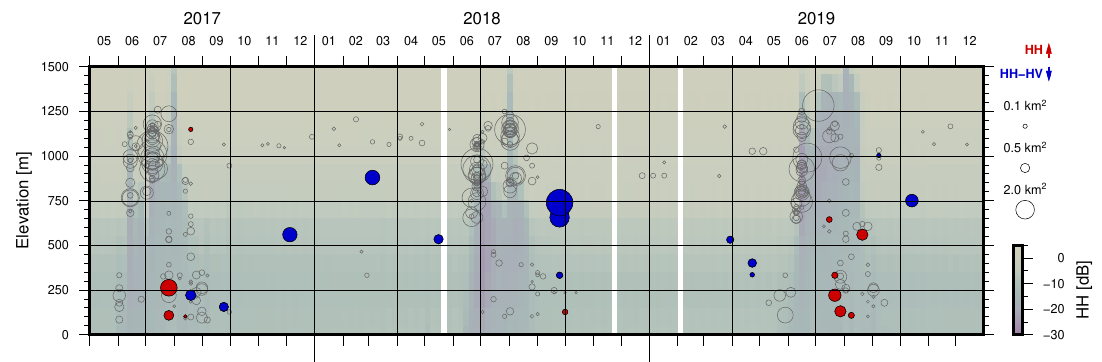
Figure 8. Supraglacial lake drainages (circles) detected by PolSAR. False drainages, identified by no significant change in backscatter, are shown in gray. The colored fill of confirmed drainages indicates the type of backscatter change. The area of drained water is represented by the